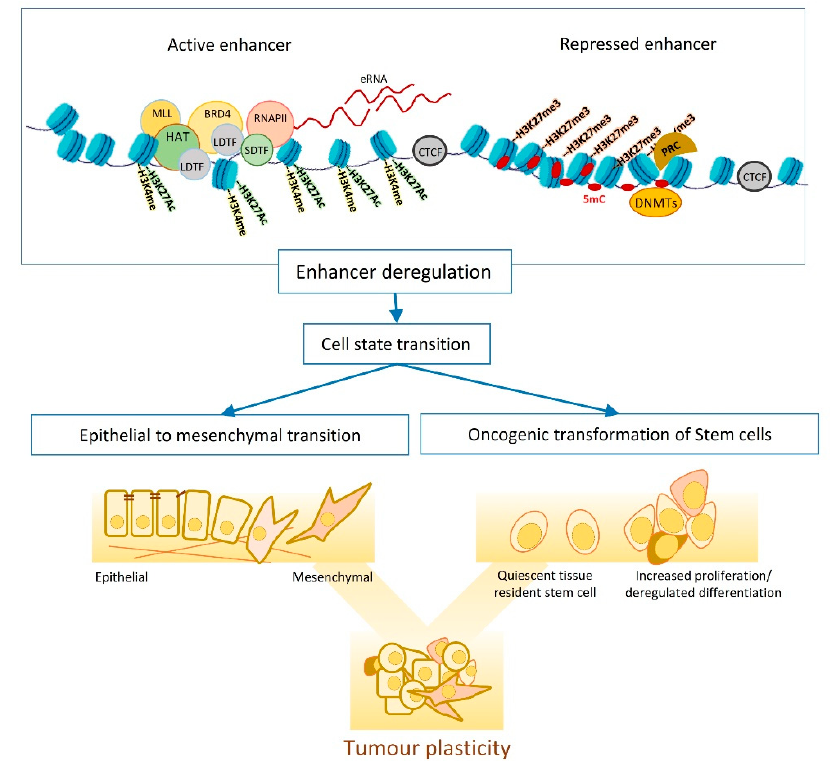
Figure 1. Schematic representation of the general features of active and inactive enhancers. The intra-tumour heterogeneity may arise from differentiation of cancer stem cells or EMT, two main processes that involve cell state transition and epigenetic reprogramming of transcriptional enhancers.